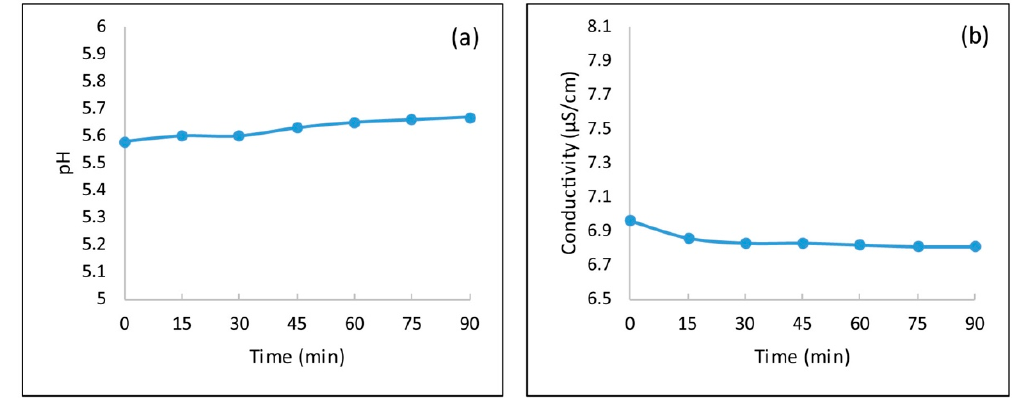
Figure 4. ( a ) pH and ( b ) conductivity of the zinc water-ferrite system as a function of the stirring time and at room temperature.